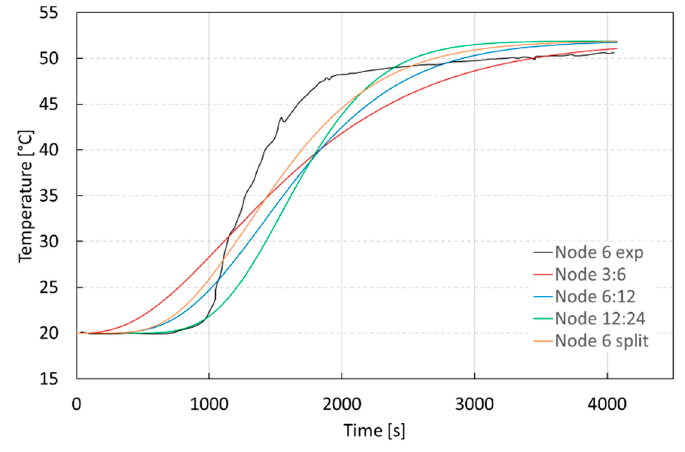
Figure 12. Experimental temperature evolution during the charge phase at node #6 vs. simulation results.